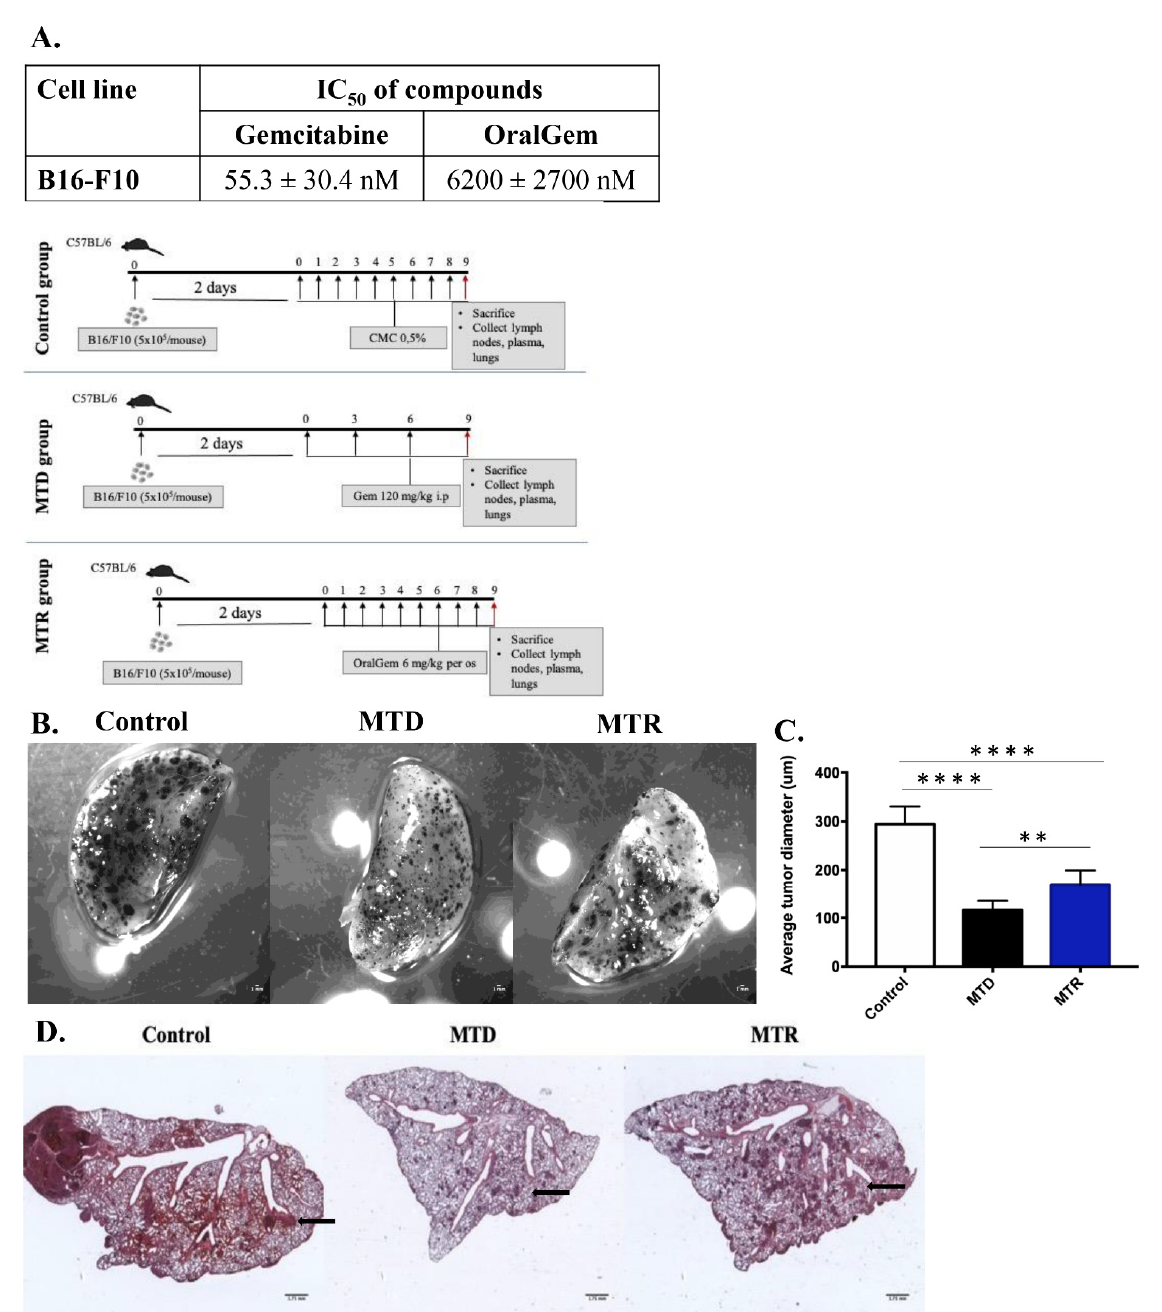
Figure 3. Efficacy evaluation of OralGem’s MTR daily administration in a mouse model of lung metastasis. ( A ) IC 50 values of gemcitabine and OralGem on B16-F10 cell line. Experiments were performed in triplicates, and statistical analysis was performed via t -test (n = 3). ( B ) The efficacy of MTD and MTR chemotherapy was evaluated stereoscopically. Male C57BL/6 mice were injected via the tail vein with B16-F10 cells (5 x10 5 cells). Two days after cell inoculation, mice were divided randomly into 3 groups. The MTD group ( n = 7) received i.p. gemcitabine (120 mg/kg) for 3 times in a period of 9 days. The MTR group ( n = 7) received per os OralGem (6 mg/kg) 8 times in a period of 9 days. The control group ( n = 8) received per os 0.5% CMC for 8 times in a period of 9 days (set of experiments = 2). ( C ) Average tumor diameter is shown. Data are mean ± SD. Statistical analysis was performed by Student’s t -test; ** p < 0.01 and **** p < 0.0001. ( D ) Hematoxylin and eosin (H&E) staining of the big lung lobe as indicated (1 × magnification